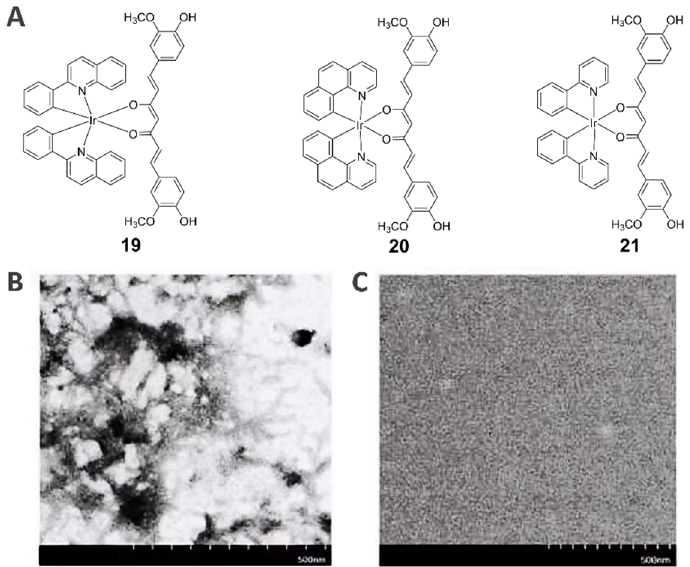
Figure 14. ( A ) Chemical structures for complexes 19−21. Inhibition of seed-induced Aβ42 fibrillation by complex 21 shown by TEM images of Aβ42 fibrillation in the ( B ) absence or ( C ) presence of 50 μM of complex 21 . Reproduced with permission from ref. [34]. Copyright 2021 Elsevier.